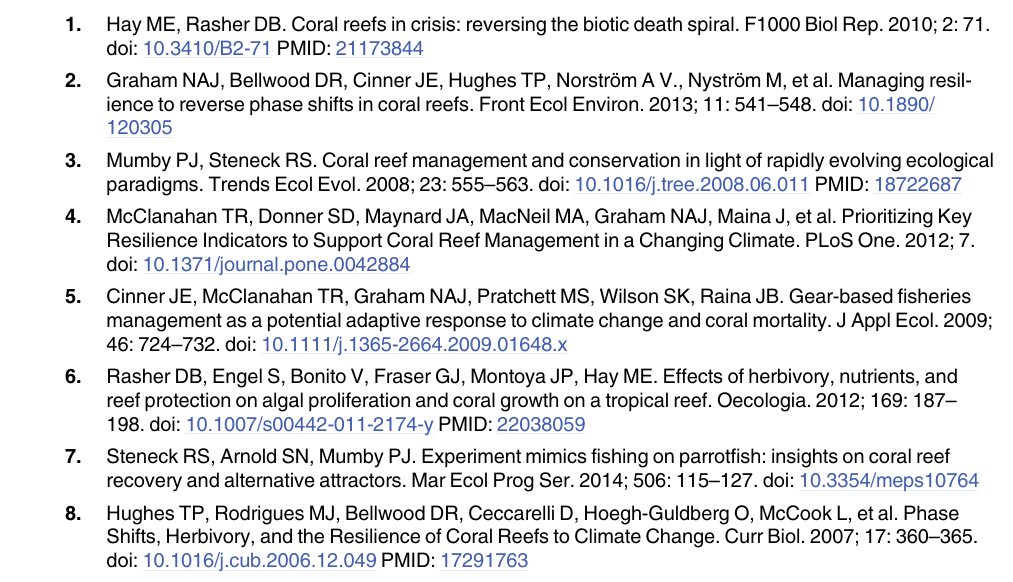
S2 Table. Mean and SE of parrotfish and surgeonfish biomass before closure (2008 – 9) and in 2 most recent year (2014 – 15) at KHFMA and at comparative locations around Maui. and are shown in bold. Kahekili HFMA data are shown for all fishes recorded during Kahekili surveys, and for the subset of fishes recorded at comparable sites (i.e. fishes > 15 cm TL, and excluding two common small-bodied surgeonfishes, A . nigrofuscus and Z . flavescens . S3 Table. Mean and SE of cover of hard coral and crustose coralline algae (CCA) before clo- sure (2008 – 9) and in 2 most recent year (2014 – 15) at KHFMA and at comparative locations around Maui. 95% quantile range (95%QR) not overlapping zero indicates significant change at alpha = 0.05, and are shown in